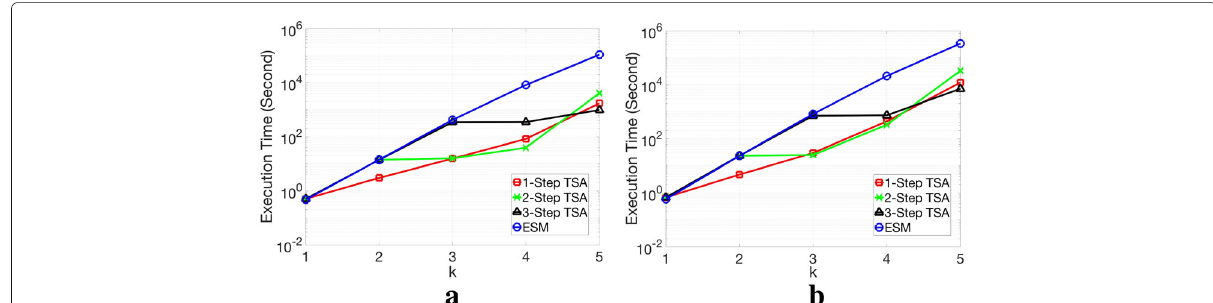
Fig. 5 The execution time of TSA in log scale as a function of k on randomly chosen m × n Gaussian matrices, where m = n / 2. a n = 40 b n = 50